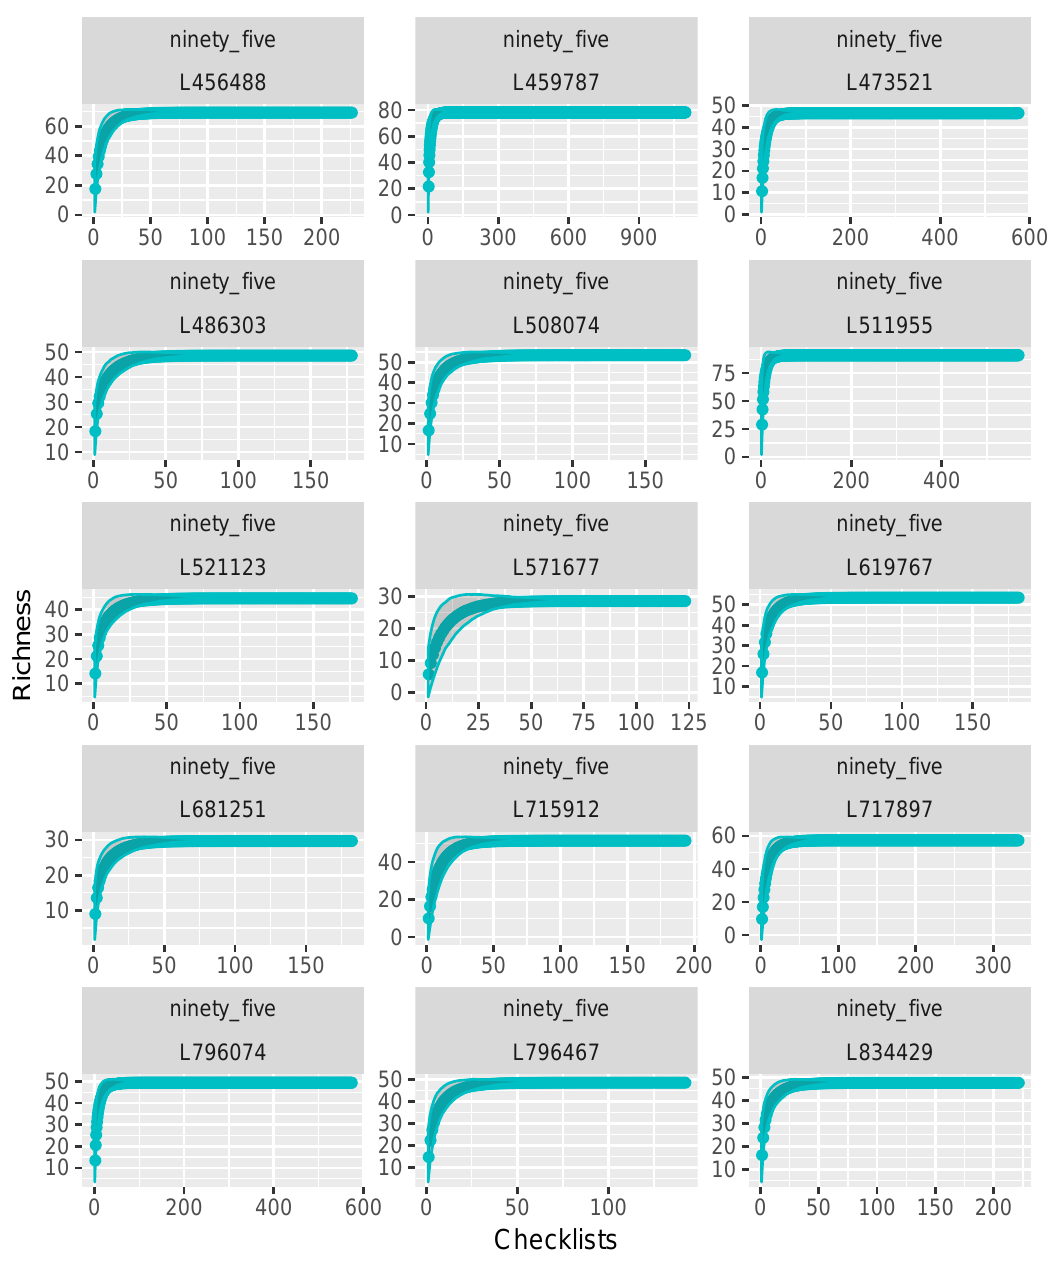
Figure. A4.1. Species richness accumulation curves for each of 30 North American greenspaces, presented for both